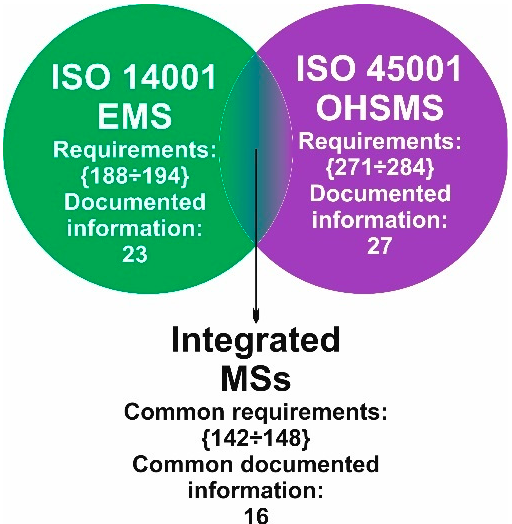
Figure 7. The intersection of EMS and OHSMS for visualized integration with the total number of common mandatory requirements and documented information (source: authors).